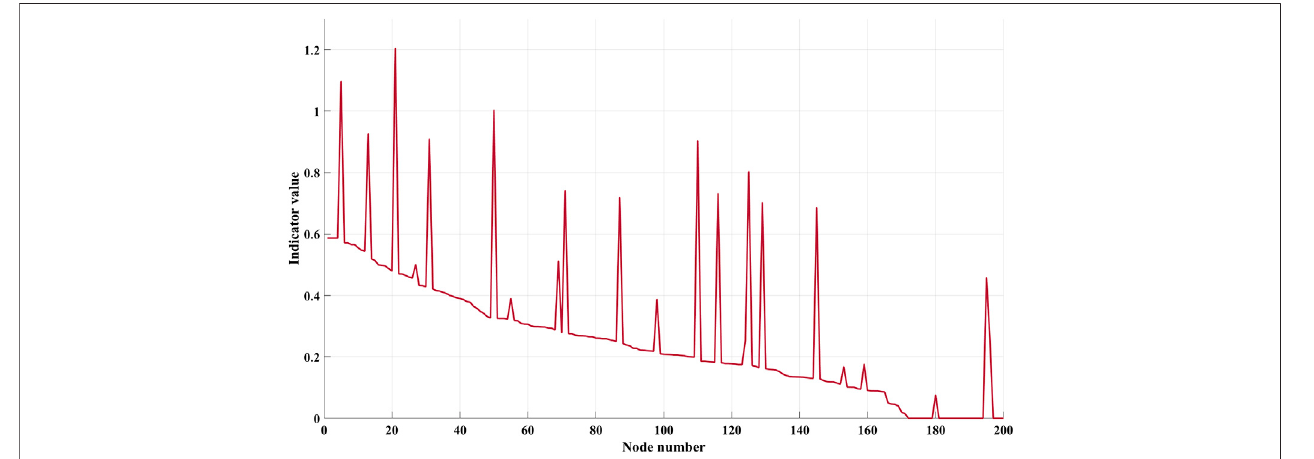
FIGURE 8 | Comprehensive indicators for energy storage system siting.